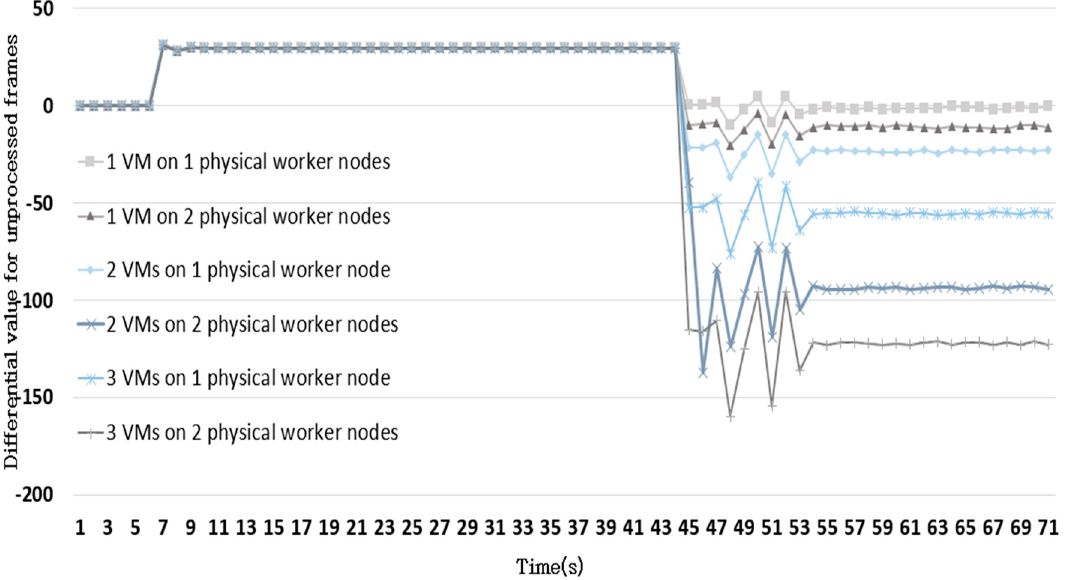
Figure 12. The amount of change in the derivative value of the unprocessed frame.